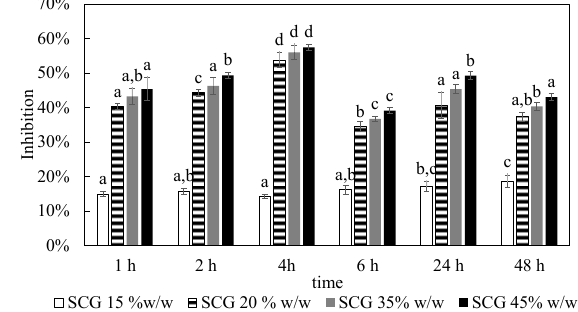
Figure 7. Results of the release tests on films obtained by electrospinning in ethanol 10% (v/v), in terms of: ( a ) caffeine released per kg of film, ( b ) radical ABTS ● + inhibition. Different symbols indicate statistically significant differences among values over time (p < 0.05) of dataset with the same extract loading.